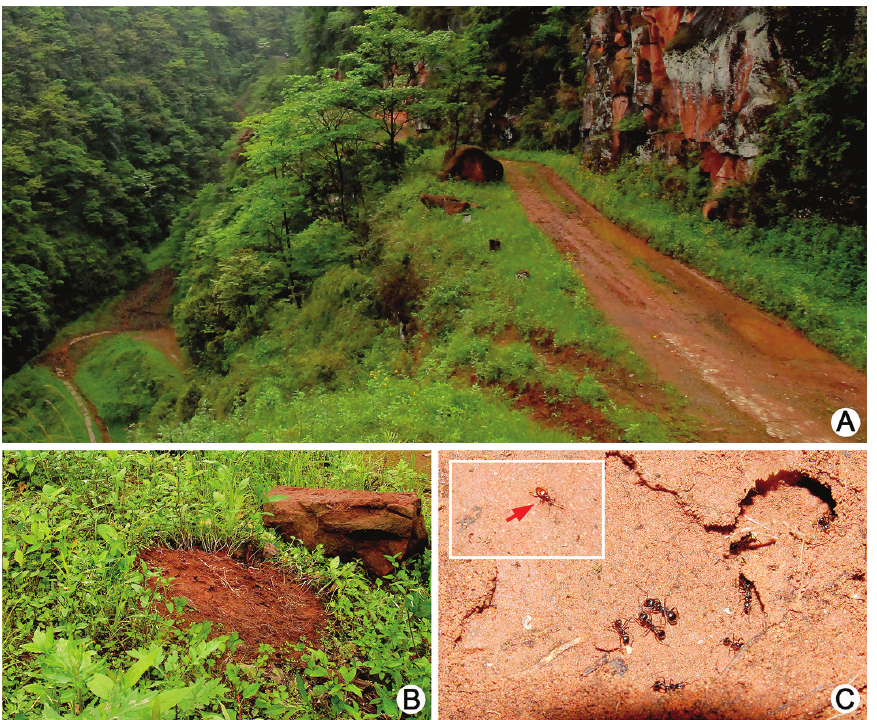
Figure 13. Habitat of Batrisodes simianshanus . A General environment B Ant nest exposed after the stone was turned over C A closer view of ant nest and a living Batrisodes simianshanus walking on the surface of ant